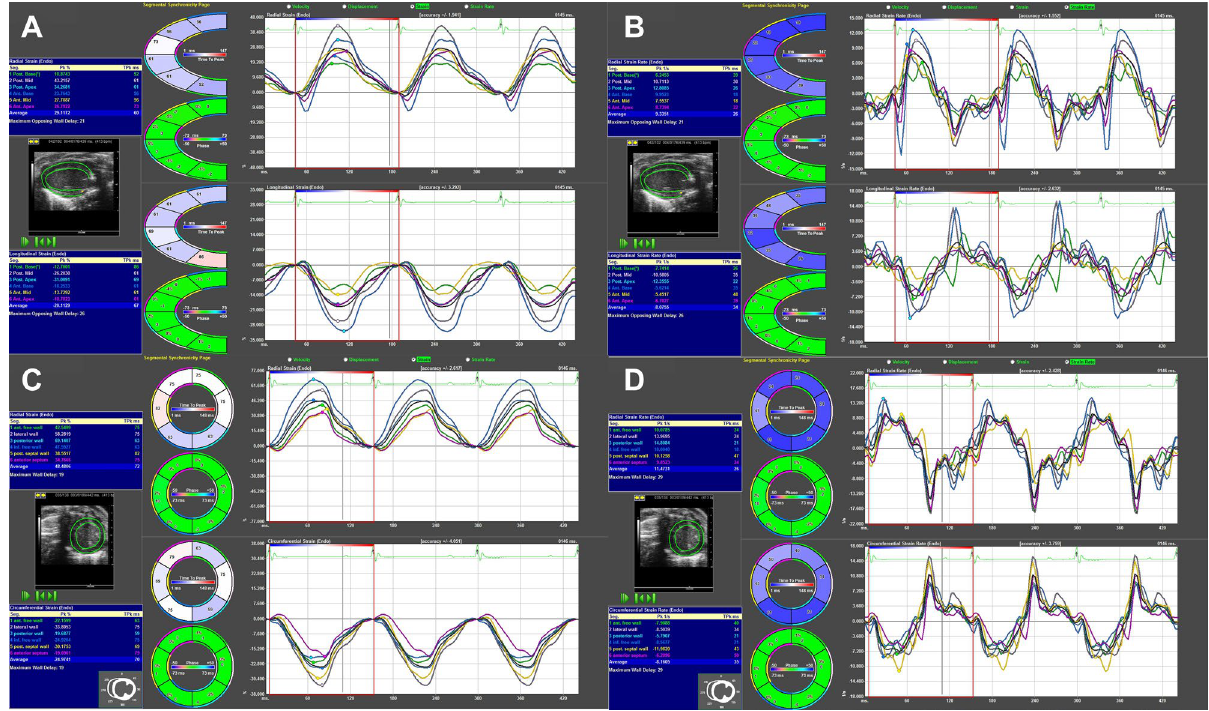
Figure 2. Global and regional strain and strain rate analyses in parasternal long-axis and short-axis view. ( A ) GLS and RLS analyses in parasternal long-axis view. ( B ) GLSR and RLSR analyses in parasternal long-axis view. ( C ) GCS, RCS, GRS, and RRS analyses in parasternal short-axis view. ( D ) GCSR, GRSR, RCSR, RRSR analyses in parasternal short-axis view. * GLS global longitudinal strain; GLSR global longitudinal strain rate; RLS regional longitudinal strain; RLSR regional longitudinal strain rate; GCS global circumferential strain; GCSR global circumferential strain rate; RCS regional circumferential strain; RCSR regional circumferential strain rate; GRS global radial strain; GRSR global radial strain rate; RRS regional radial strain; RRSR regional radial strain